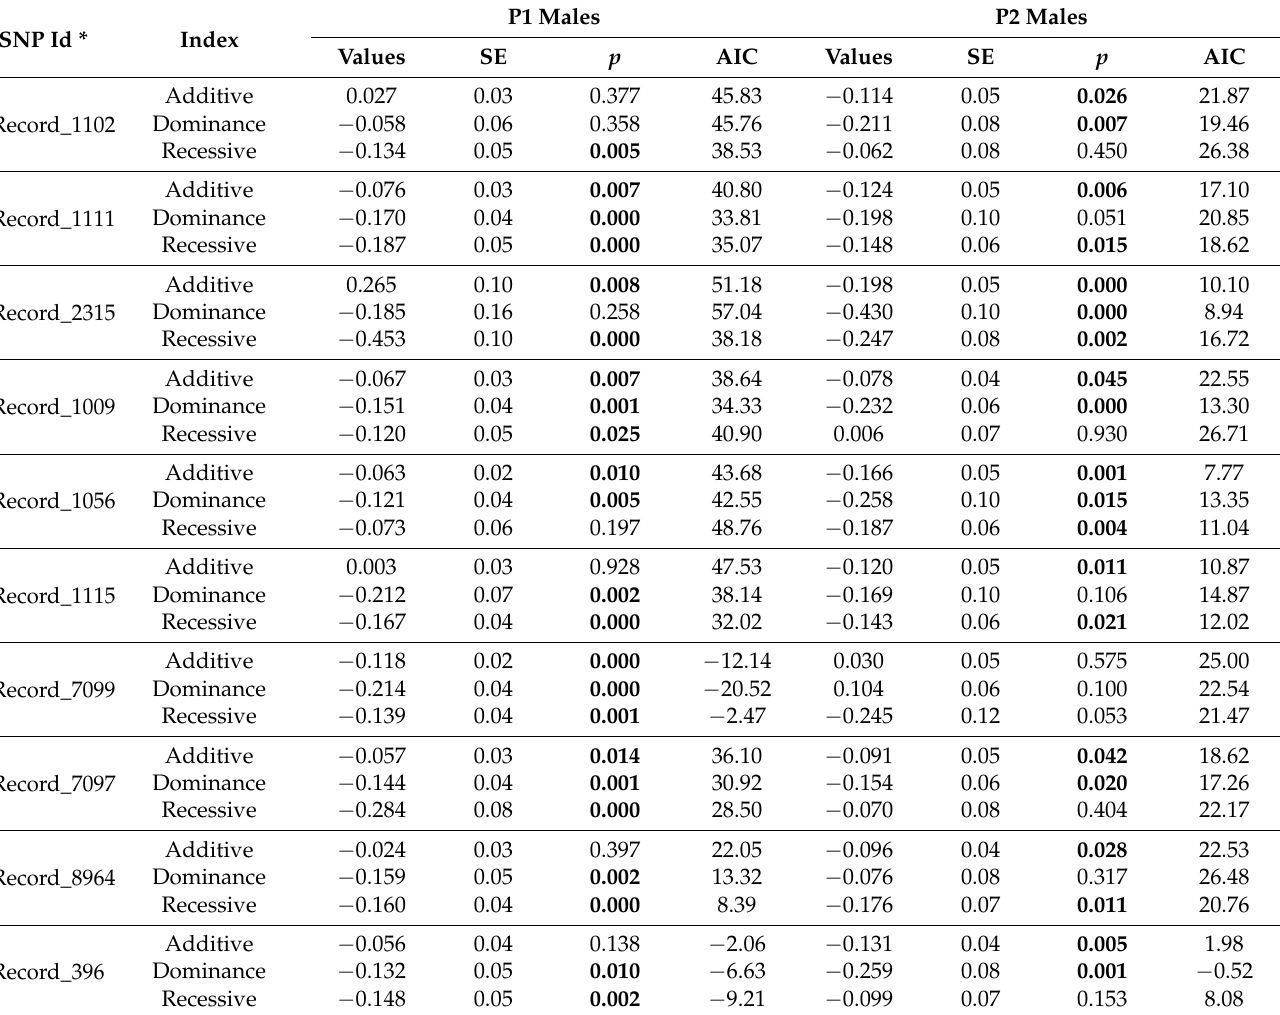
Table 3. The genotypic effects of the 10 SNPs of males in the first and second populations.